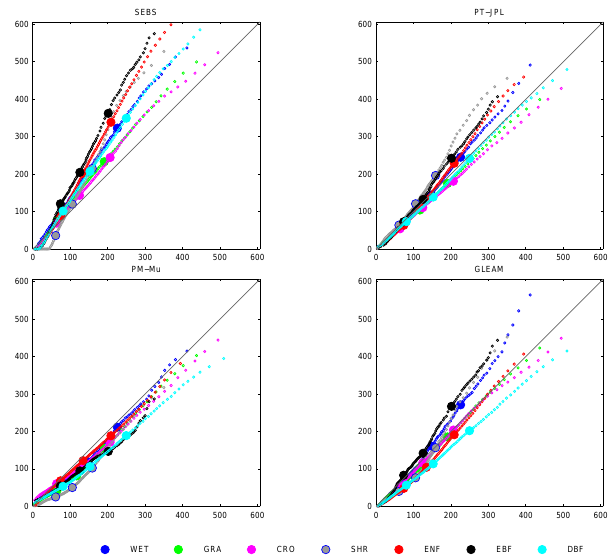
Figure 6. Percentile plots of observed ( x axis) vs. estimated latent heat flux ( y axis) at 3-hourly resolution for the tower-based analysis across the seven studied biomes. Percentiles encompass the 1st to 99th range in 1 percent increments, with Q 25 , Q 50 and Q 75 denoted by large coloured